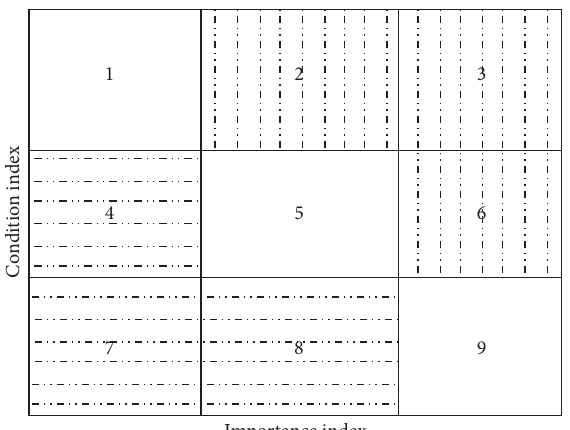
Figure 2: Decision making map for preventive maintenance scheduling of transmission lines.